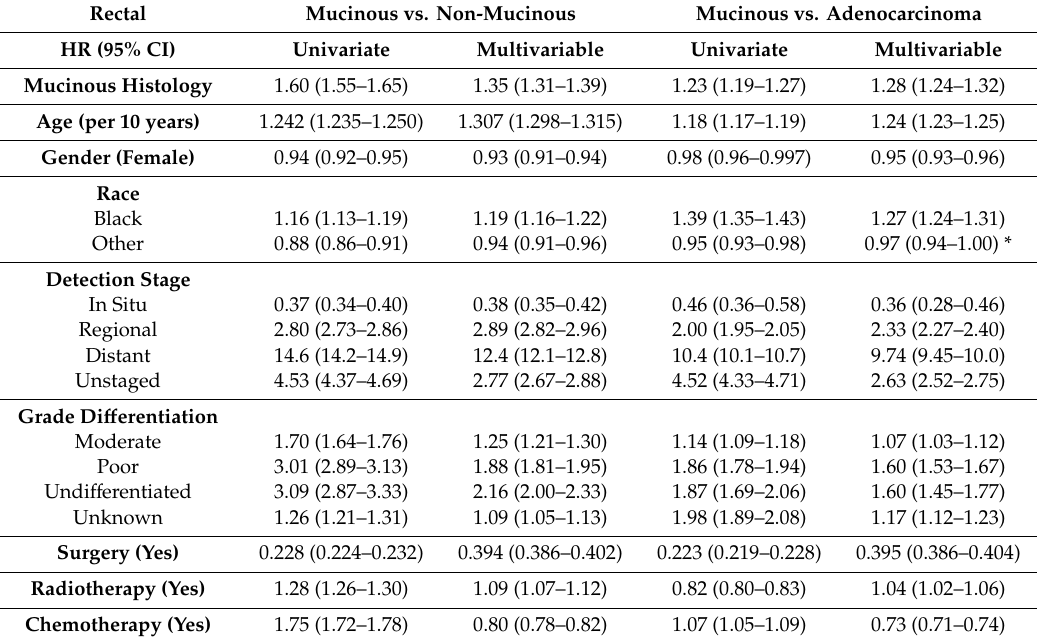
Table 8. Derived univariate and multivariable Cox-proportional hazard ratios (HR) of mortality for rectal cancers.